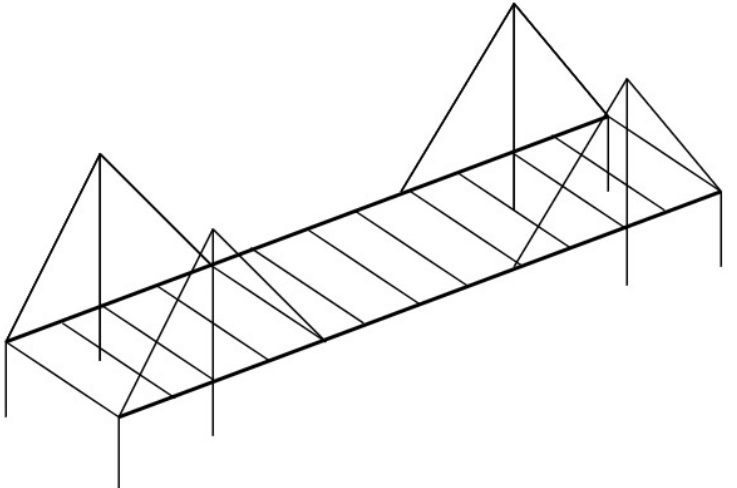
Figure 3. Double-girder model.